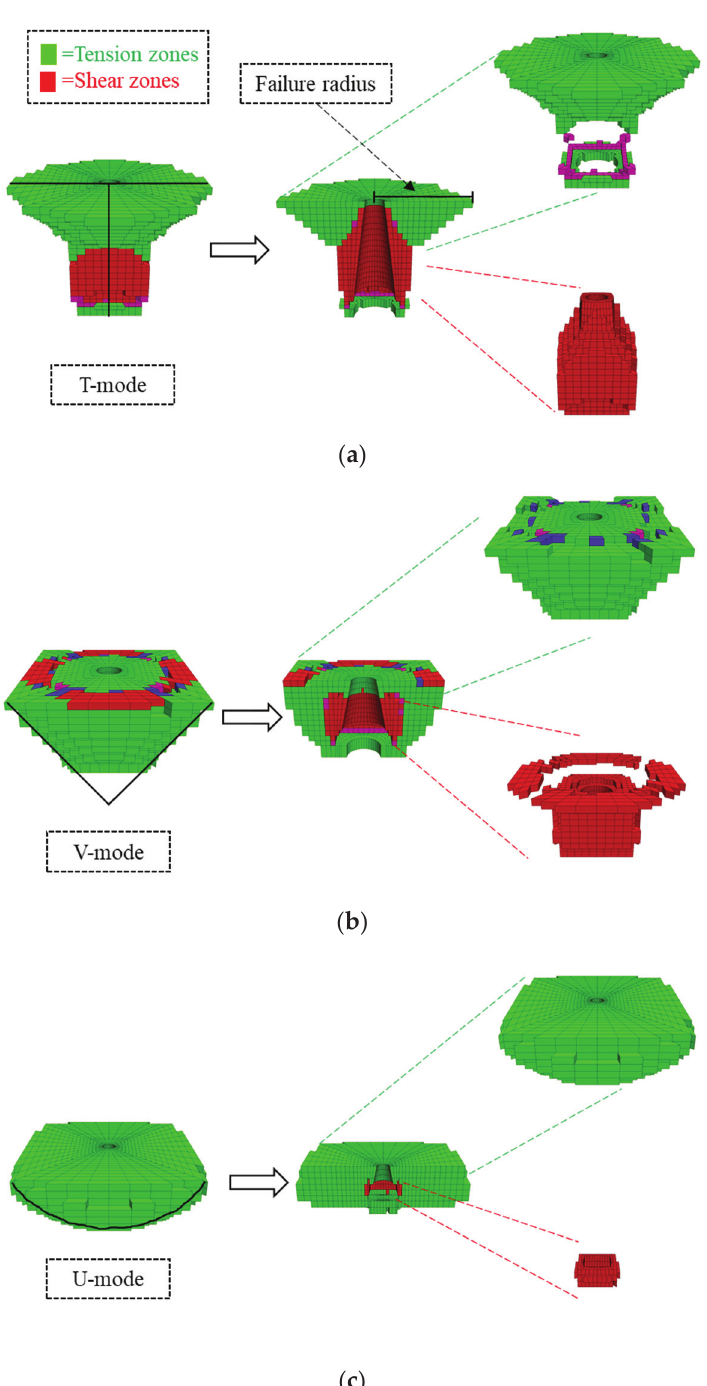
Figure 17. Three typical failure mechanisms of frozen soil: ( a ) T-mode; ( b ) V-mode; and ( c ) U-mode.